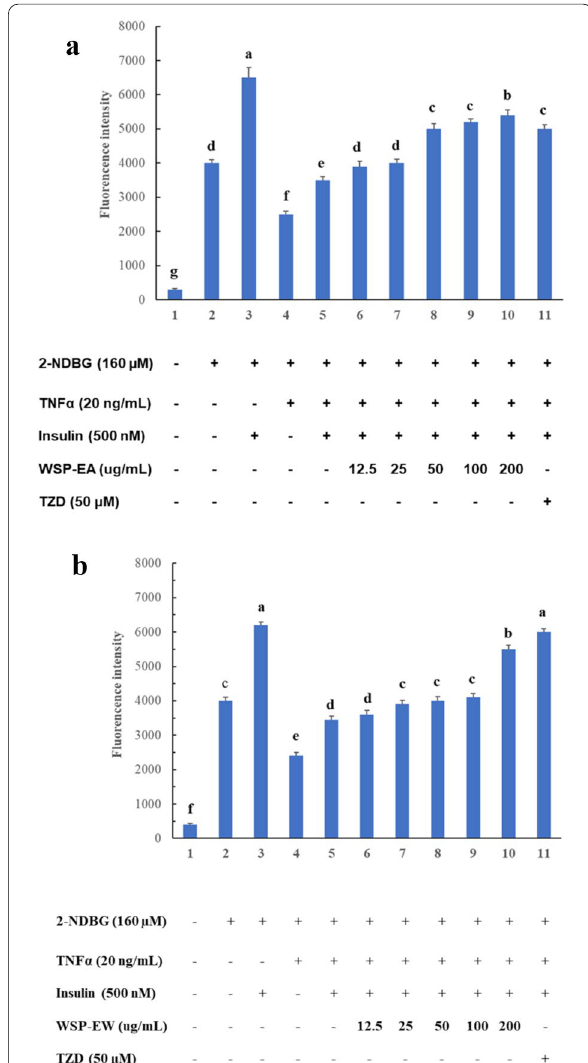
Fig. 4 Glucose uptake evaluation of different concentration of WSP extracts on C2C12 myotubes. C2C12 cells were differentiated to myotubes in DMEM‑high glucose plus 2% horse serum, further insulin resistance was induced by TNF‑α (20 ng/mL) for 24 h. The different concentration of WSP‑EA fraction (12.5 µg/mL to 200 µg/ mL) ( A ) and WSP‑EW fraction ( B ) were used to quntified the uptake of glucose analog 2‑NBDG by flow cytometry. TNF-α tumor necrosis factor alpha, WSP-EA white sweet potato ethyl‑acetate fraction, WSP-EW white sweet potato water fraction. TZD thiazolidinedione. Values were presented as mean SD of 3 independent experiments ± performed in triplicate, and were analyzed using one‑way ANOVA, followed by a post hoc Tukey’s test for multiple comparisons. Different letters above the error bars indicate significant differences among treatments ( P <